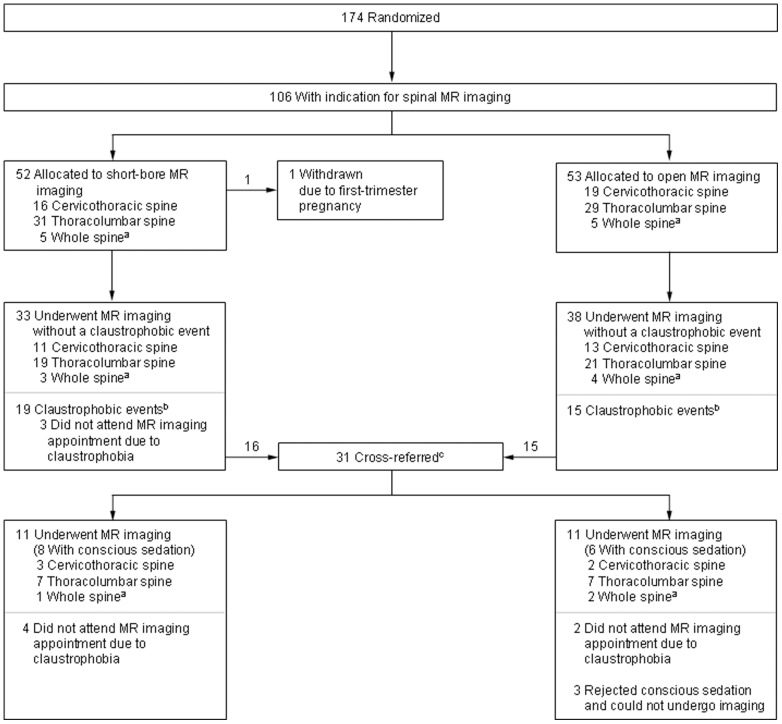
Randomization, Anatomical Regions, and Claustrophobic Events in the Study.Ninety-three of the 106 patients with a clinical indication for spinal MR imaging underwent an MR examination in our study. aFor the analysis, MR imaging of the whole spine was categorized as imaging of the cervicothoracic and the thoracolumbar spine. bA claustrophobic event was defined as the inability of a patient to undergo MR imaging due to claustrophobia. All but one patient with a claustrophobic event rejected MR imaging before the examination started. The one patient aborted MR imaging on the short-bore MR scanner after acquisition of one sequence, which could thus not be included in the analysis. cPatients were cross-referred for a second MR examination on the other scanner if they could not bear imaging on the first scanner in order to avoid the risks of conscious sedation. Only patients who could not undergo MR imaging in either of the two scanners received conscious sedation (IV midazolam) according to the American Society of Anesthesiology guideline [18]. Sedation was performed using IV midazolam (sedation success rate 100%, no adverse events). Examinations performed after cross-referral, with or without sedation, were included in the primary analysis.